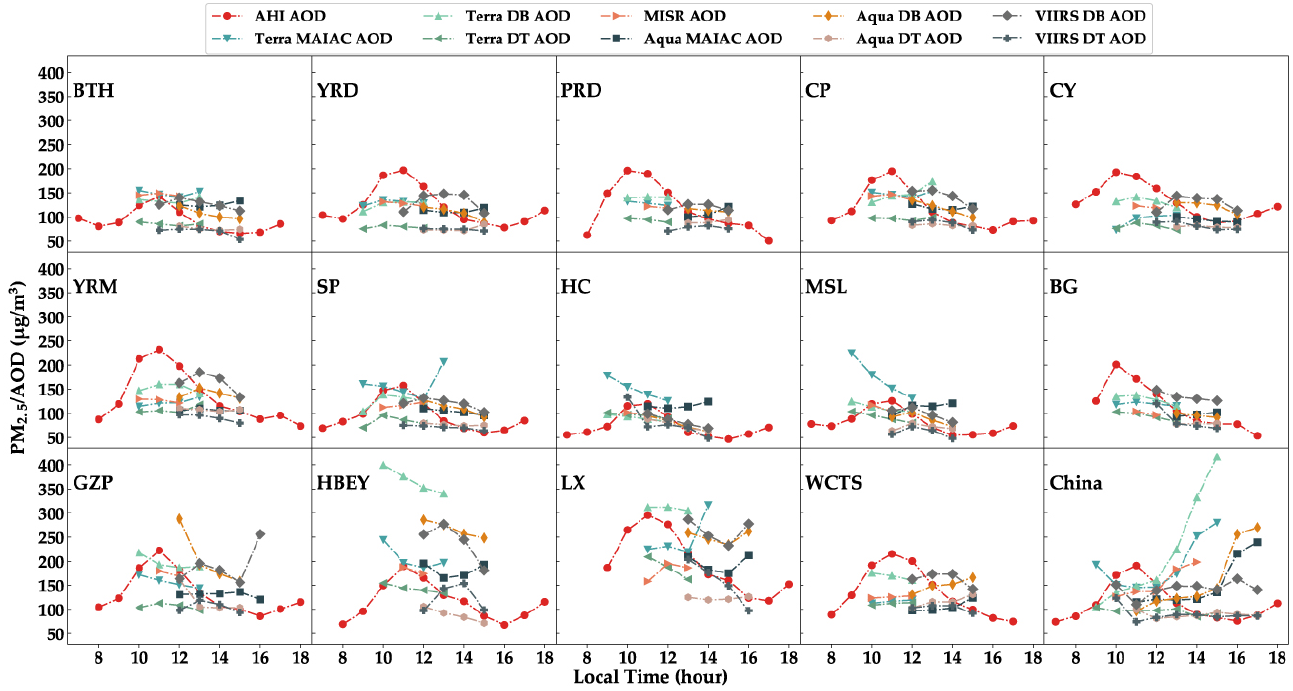
Figure 4. The daily variation in the correlation coefficients (R) between the PM 2.5 concentration and LEO/GEO satellite AODs. For the LEO satellite, the observation/overpass time found in each AOD file is the local time hour. The Terra’s overpass time in various regions of China is typically between 10:00 and 13:00, while the Aqua’s time is typically between 12:00 and 15:00.